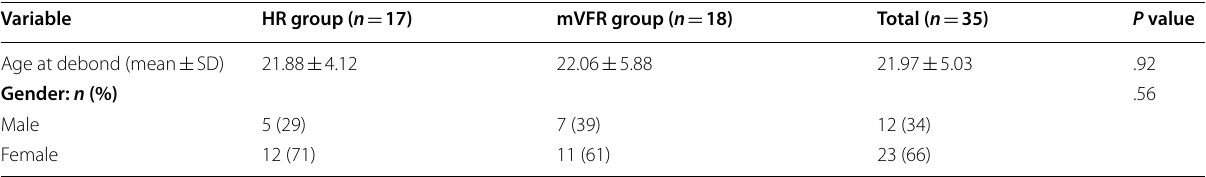
Table 2 Age and gender distribution of subjects for the groups